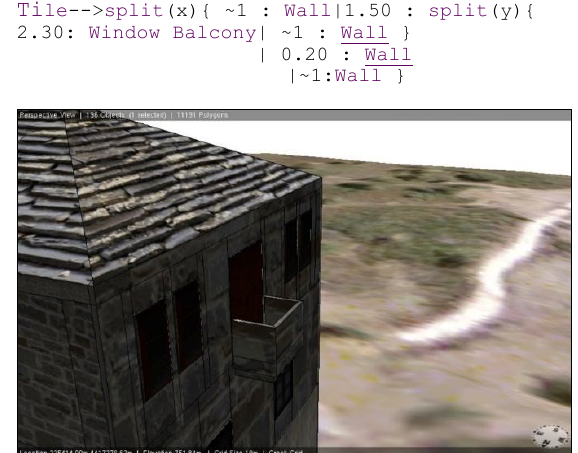
Figure 8. Detail of generated Balcony asset